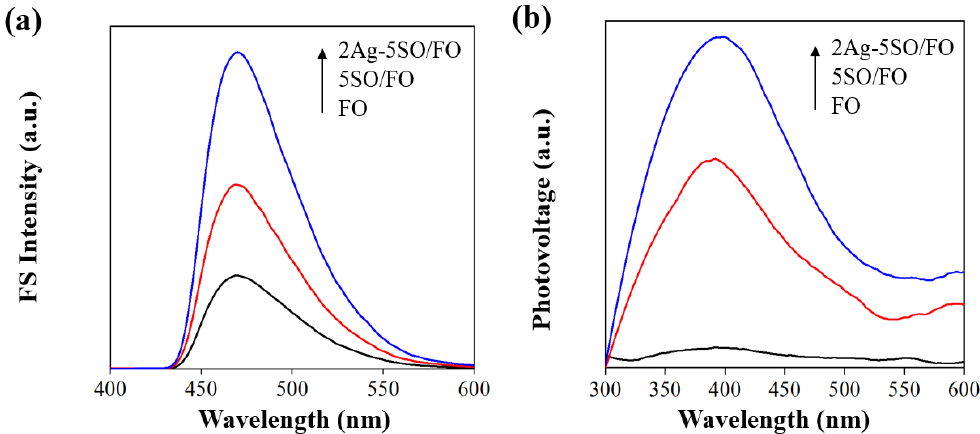
Figure 3. ( a ) FS related to produced hydroxyl radicals under visible-light irradiation and ( b ) SS-SPS signals for FO, 5SO/FO, and 2Ag-5SO/FO, respectively.